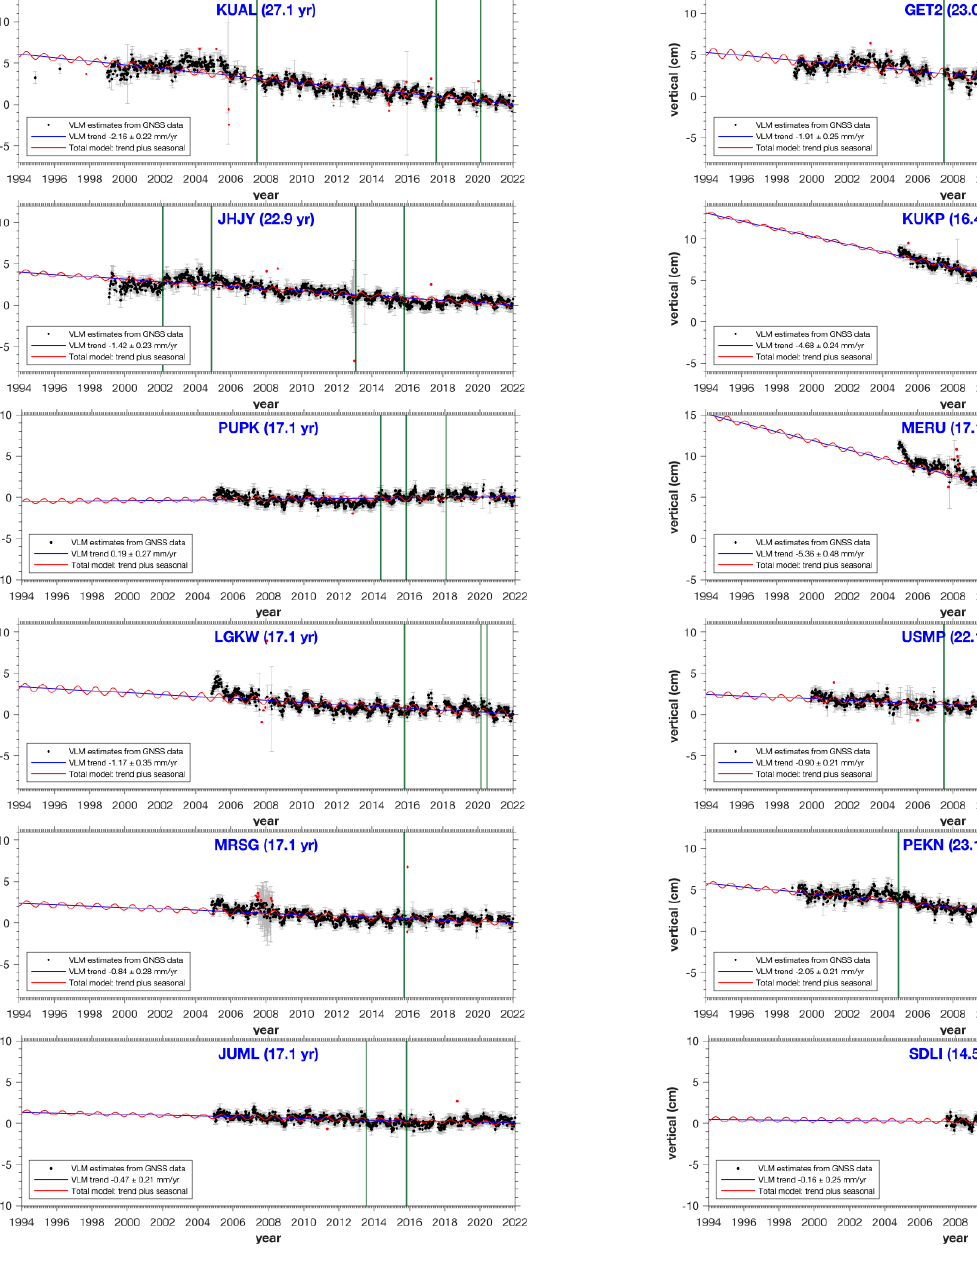
Figure 6. VLM estimates from 12 MyRTKNet stations located near the TG stations in Peninsular Malaysia. The vertical position time series for each station, as well as the overall observation period, are provided. The vertical reference position is specified on 1 January 2002 (0 cm). The green vertical lines are the epochs at which a vertical position jump (due to antenna change or MASS to MyRTKNet transition) was estimated. The linear trend line is given in blue, with the modelled seasonal (annual) signal superimposed on it. The VLM estimates come from the linear regression through the weekly averaged positions (black dots). Weekly averaged position outliers are marked in red. The VLM estimate is given at a confidence level of 95% (1.96